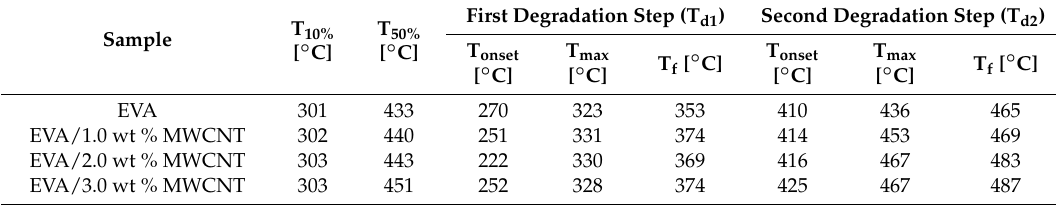
Figure 8. Thermogravimetric analysis (TGA) curves of selected samples. Table 3. Degradation temperatures at 10 and 50% mass loss for selected samples.